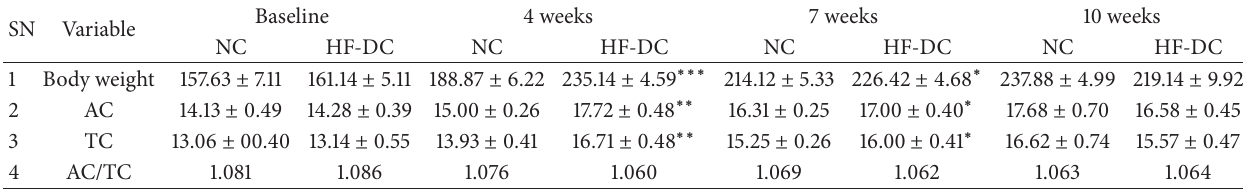
Table 1: Time course of changes in anthropometric parameters in the experimental group.